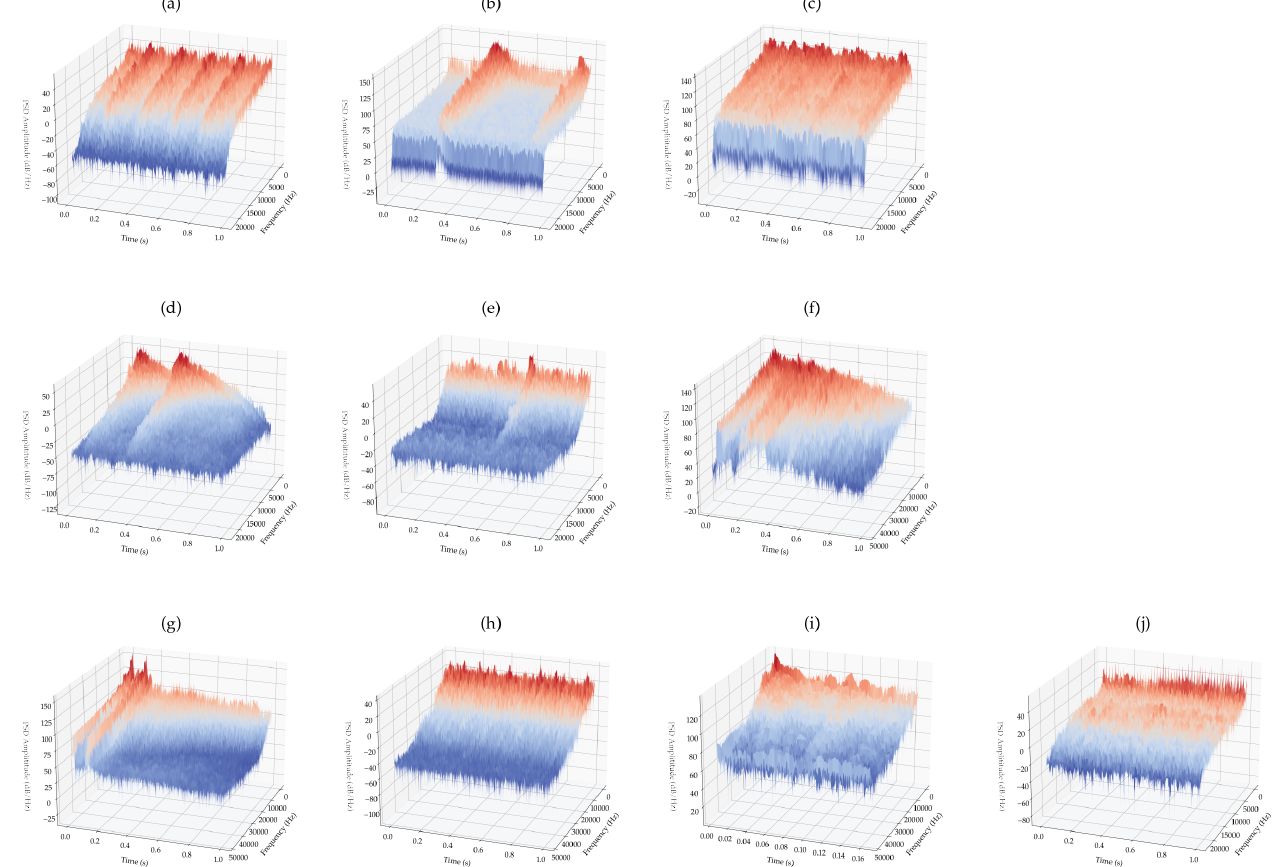
Figure 7. Waterfall plots of the various classes: : ( a ) carbackfire-0, ( b ) cardoorslam-1, ( c ) clapping-2, ( d ) doorknock_slam-3, ( e ) fireworks-4, ( f ) glassbreak_bulb-burst-5, ( g ) gunshot-6, ( h ) jackhammer-7, ( i ) plastic_pop-8 and, ( j )